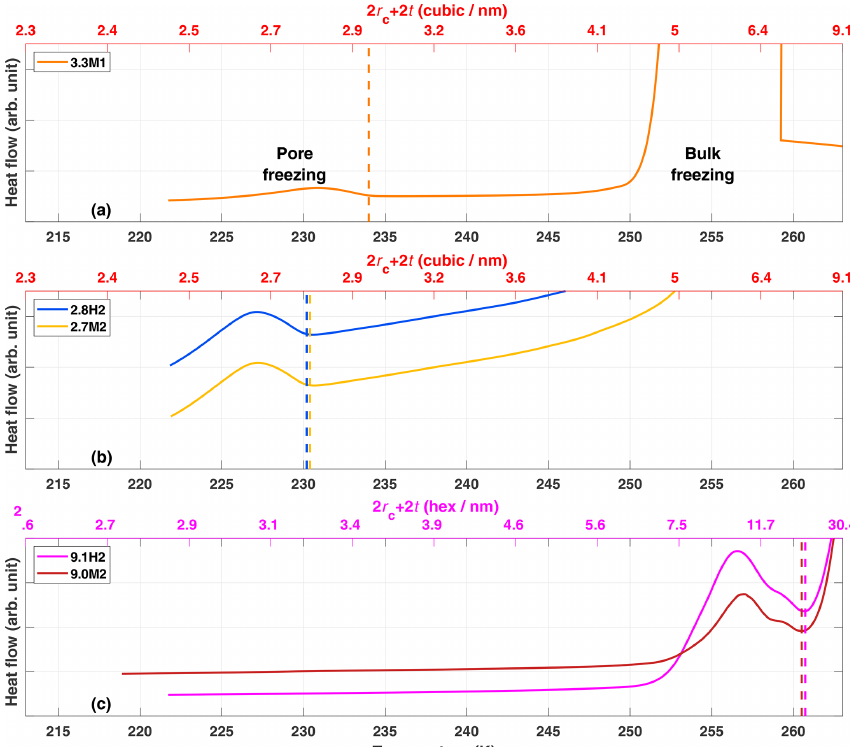
Figure 5. DSC thermograms for ice growth into pores for samples (a) 3.3M1, (b) 2.8H2 and 2.7M2, and (c) 9.1H2 and 9.0M2. The vertical dashed lines mark the observed onset temperatures of pore freezing. The upper x axes represent the predicted critical pore diameter ( 2 r c + 2 t) for cubic (red axis labels; a and b ) or hexagonal (magenta axis labels; c ) ice to be stable, following Marcolli (2014). The peak on the righthand side of panel (a) and the descending lines in panel (c) are due to the bulk freezing of exterior